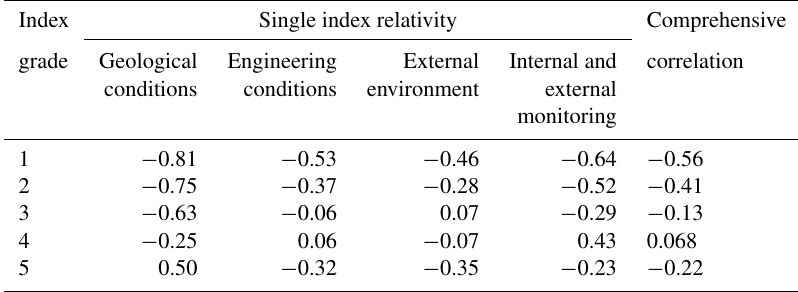
Table 9. Evaluation results of criteria level (Level 2). Index Single index relativity Comprehensive Geological